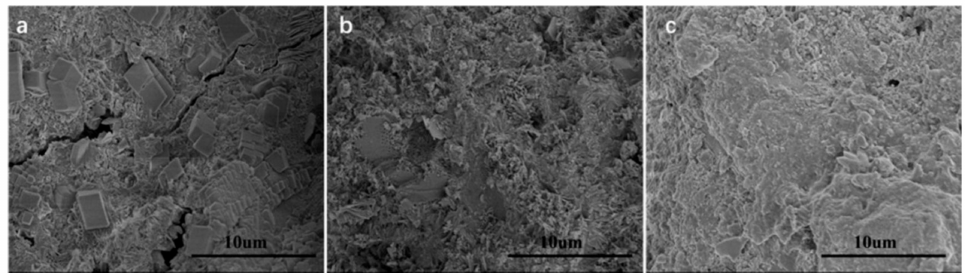
Figure 26. SEM image of the ( a ) blank OWC sample, ( b ) GO reinforced OWC specimen and ( c ) TEA-GO reinforced OWC specimen after compressive strength test at age 28 days. Reprinted with permission from [159]. Copyright © 2019, Elsevier B.V.